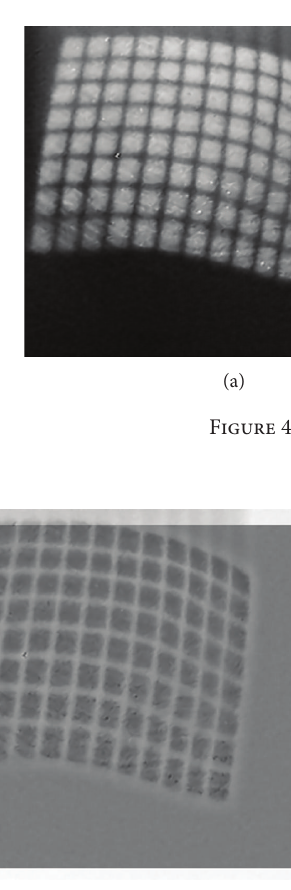
Figure 5: Intensity correction